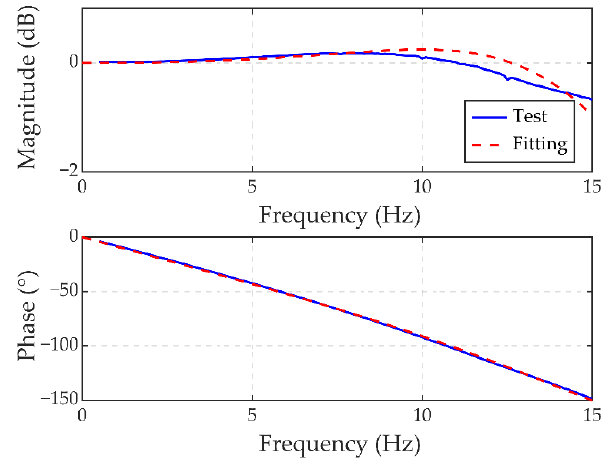
Figure 20. Bode plot of actuator.